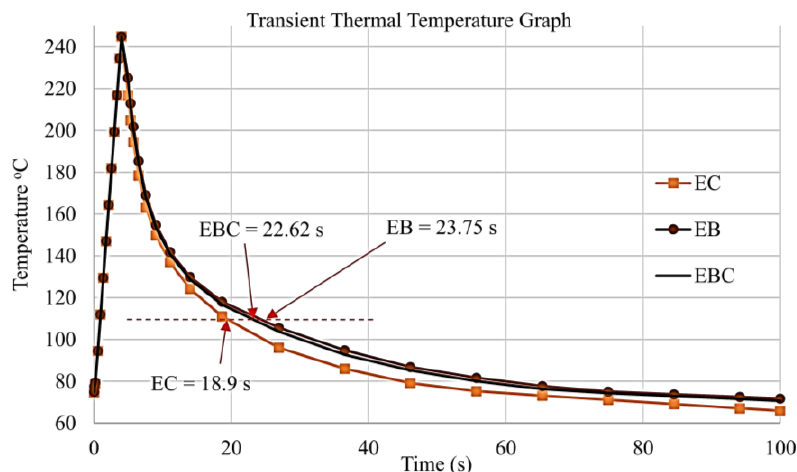
Figure 22. Transient thermal analysis graph at high thermal conductivity.